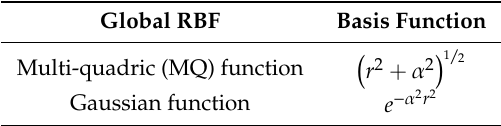
Table 1. Global RBF (Radial Basis